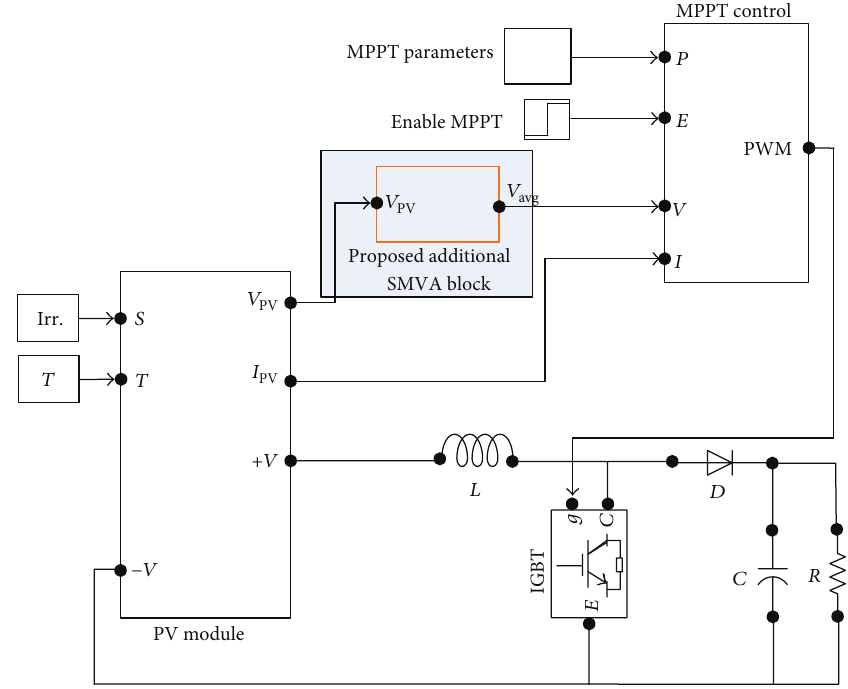
Figure 9: MATLAB/Simulink model of SMVA MPPT controller with DC-DC boost converter.